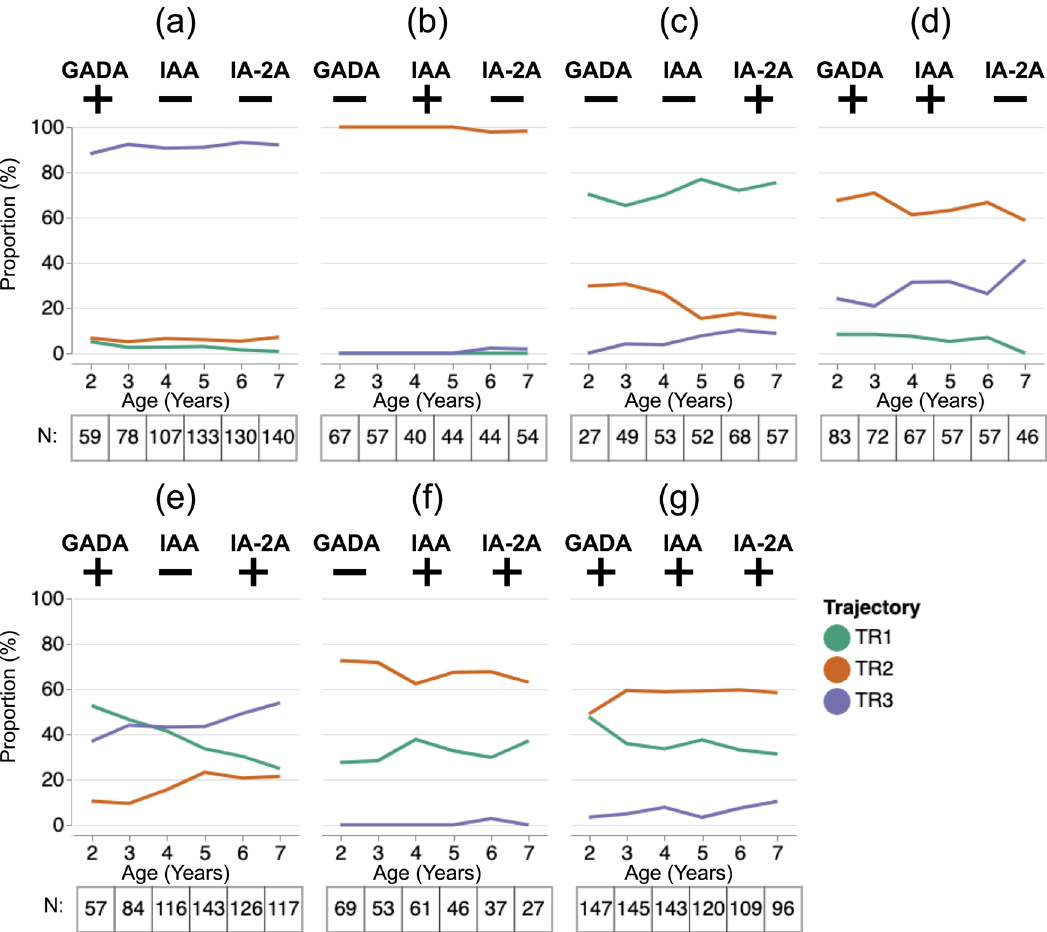
Fig. 3 Proportion of participants in the three trajectories given islet autoantibody pattern and age. Proportion ( y -axis) of participants with each of seven possible IAb patterns ( a – g ) belonging to each trajectory (TR1: green, TR2: red, TR3: purple) over the ages between 2 and 7 ( x -axis). Tables under each panel show the number of subjects who had the given IAb pattern at each corresponding age. Source data are provided as a Source Data fi le. Table 1 Distribution of undiagnosed and diagnosed participants in three trajectories over sex and HLA. Undiagnosed